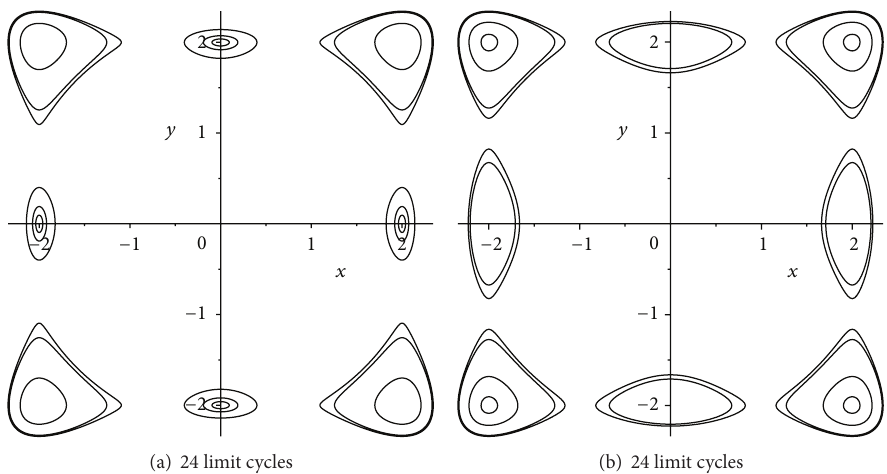
Figure 2: Two different distributions of 24 limit cycles of system